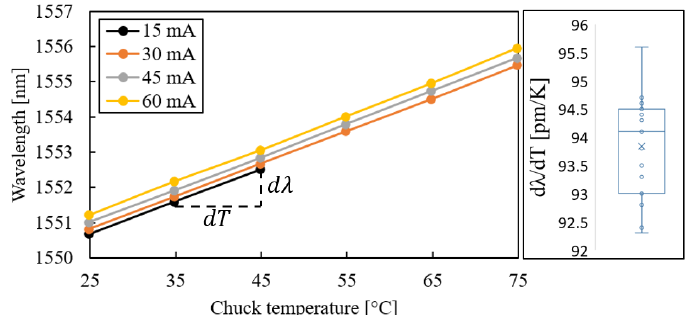
Figure 7. Laser wavelength as a function of chuck temperature for one laser and the box plot of linear fit through all slopes of the five characterised lasers.